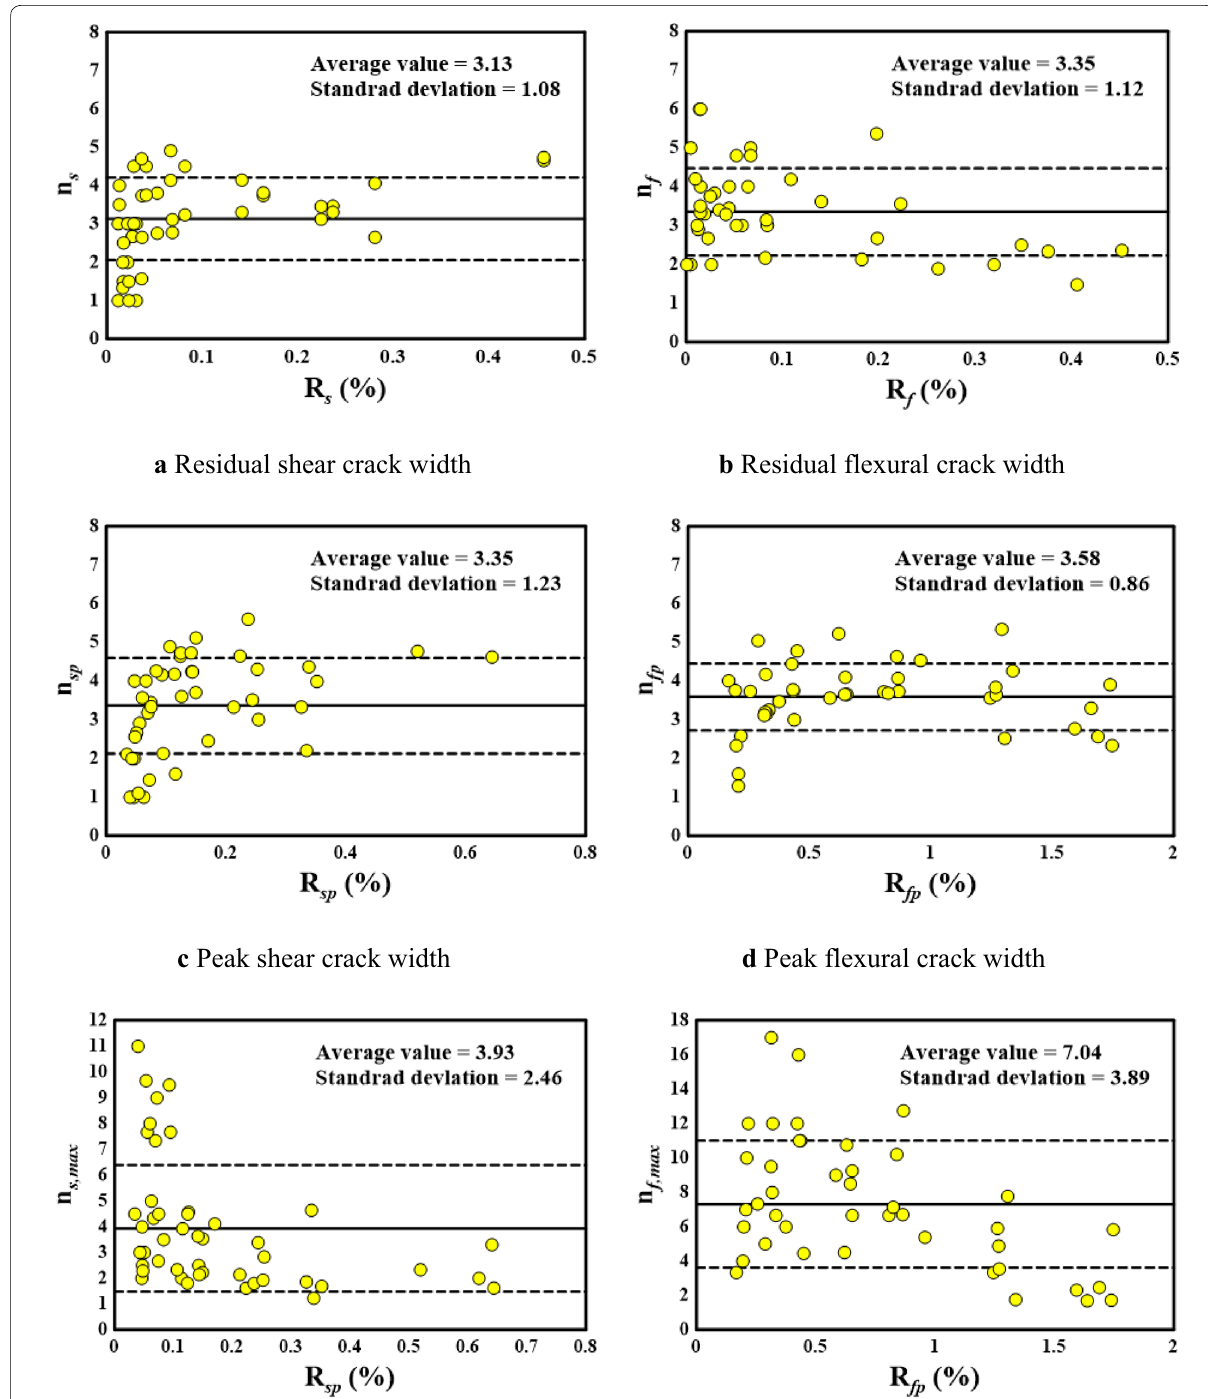
Fig. 13 Experimental values of n s , n sp , n s,max , n f , n pf , and n f,max